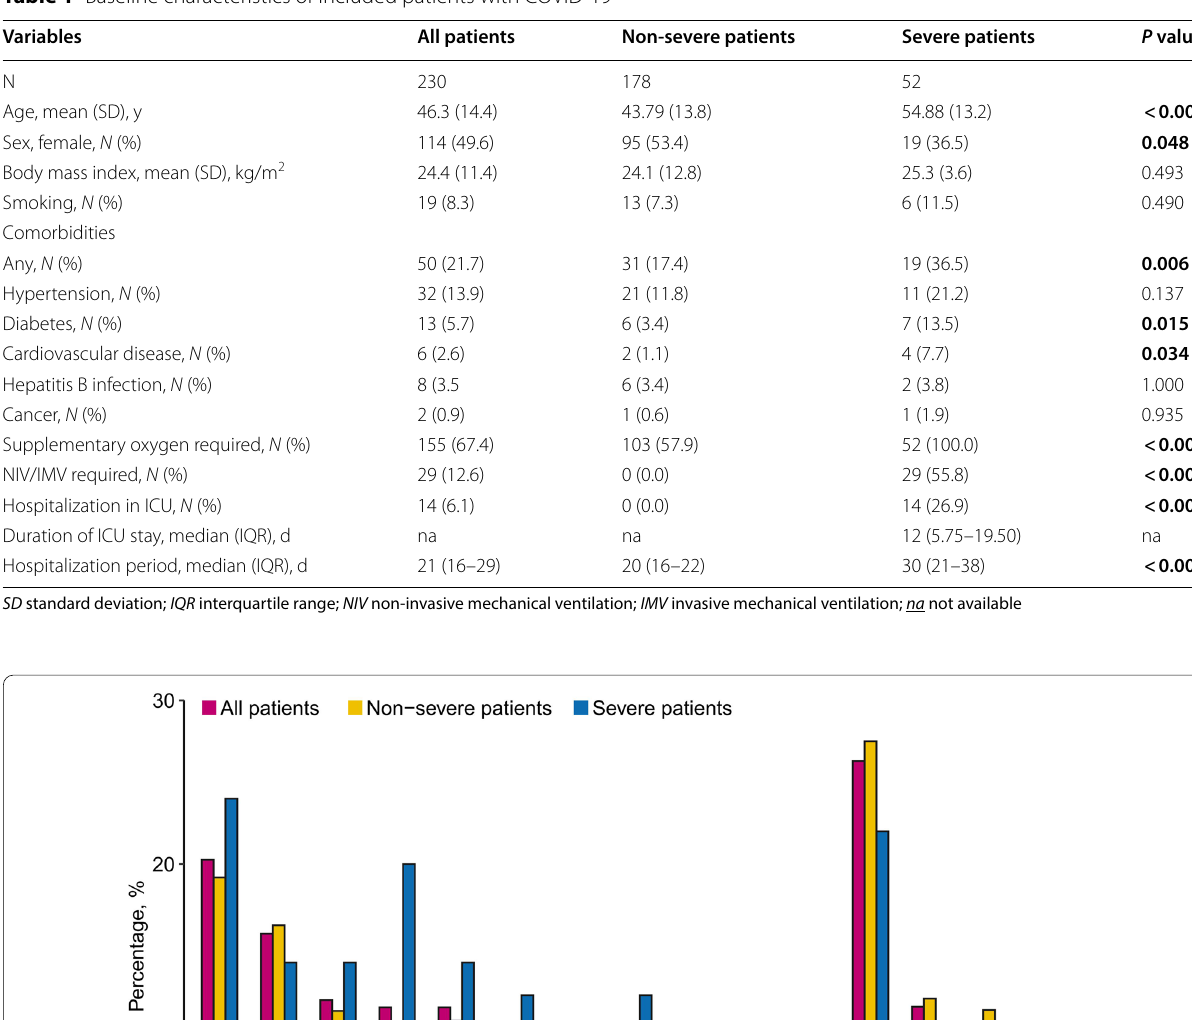
Table 1 Baseline characteristics of included patients with COVID-19